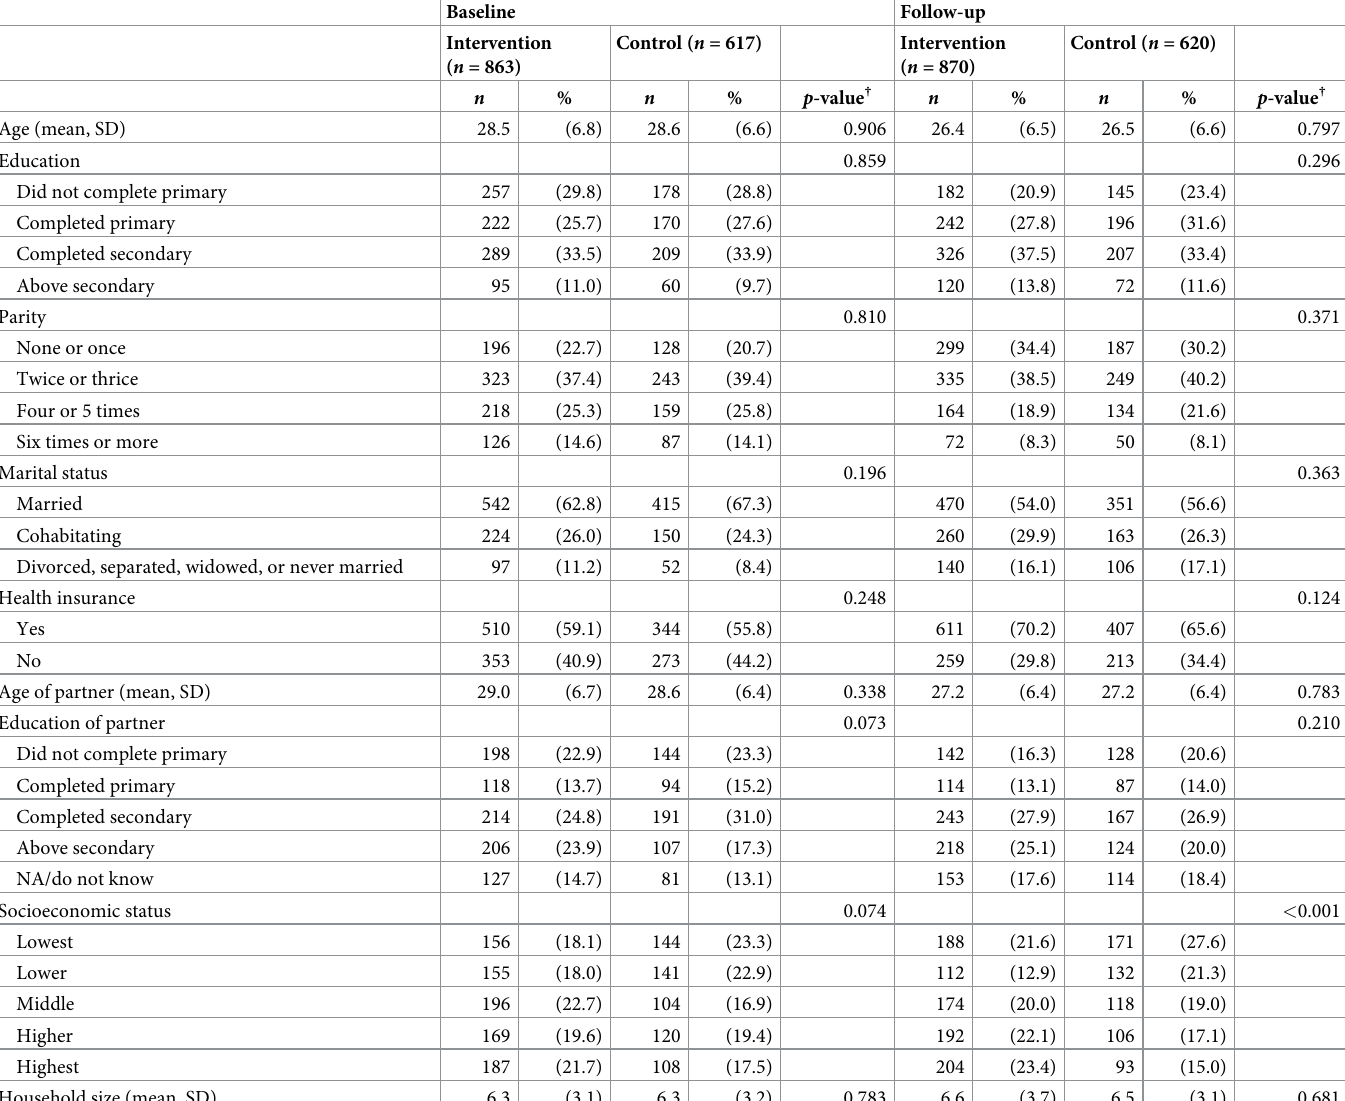
Table 4. Characteristics of women and their partners for the baseline and follow-up